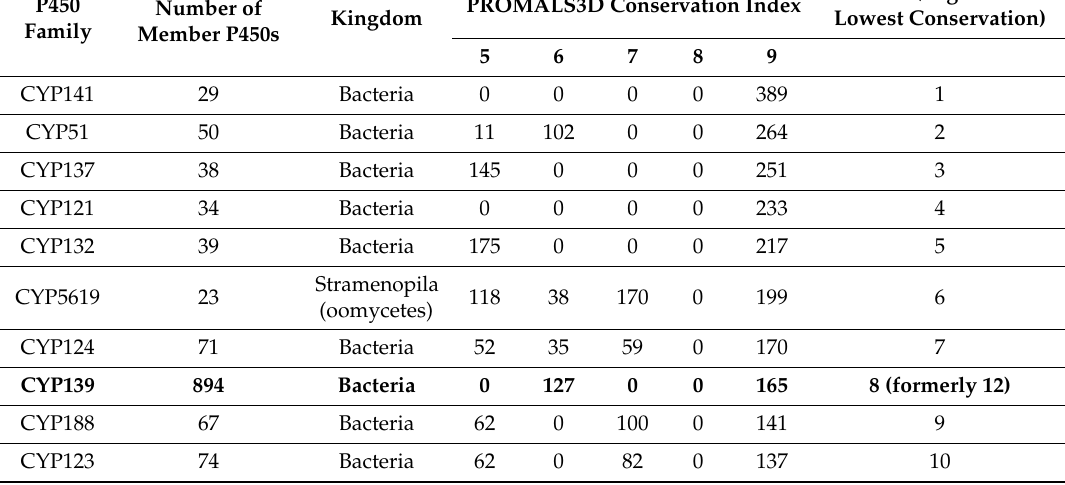
Table 1. Comparative amino acid conservation analysis of CYP139 P450 family with top 10 ranked P450 families [23,25]. The conservation index score is obtained as described in the section on materials and methods, following the procedure described elsewhere [27]. The conservation score (5– 9) obtained via PROMALS3D is presented in the table, where the number 9 indicates invariantly conserved amino acids in P450 members. P450 families were arranged from the highest to the lowest number of amino acids conserved. CYP139 P450 family is indicated in bold.